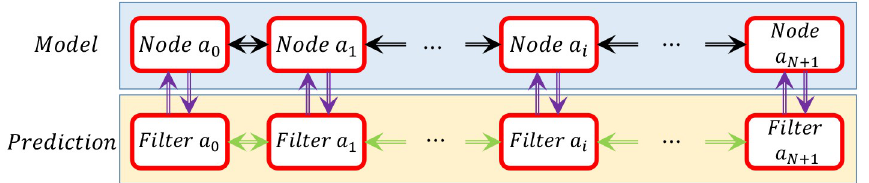
and Node a are i i